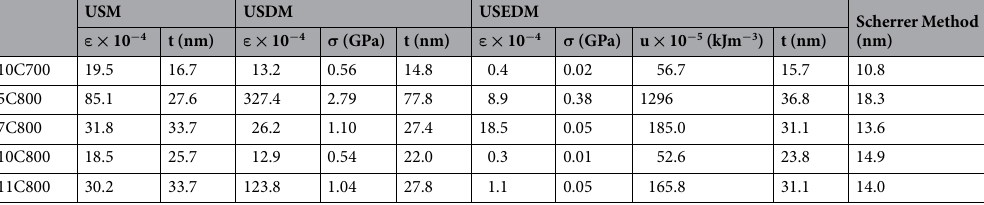
Table 2. Williamson-Hall